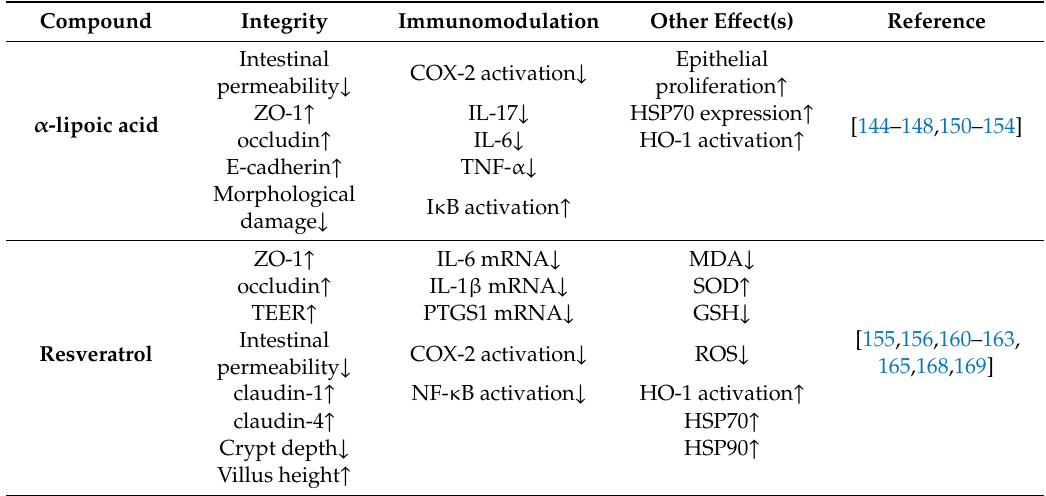
Table 2. The e ff ects of α -lipoic acid and resveratrol on intestinal integrity and immunomodulation.